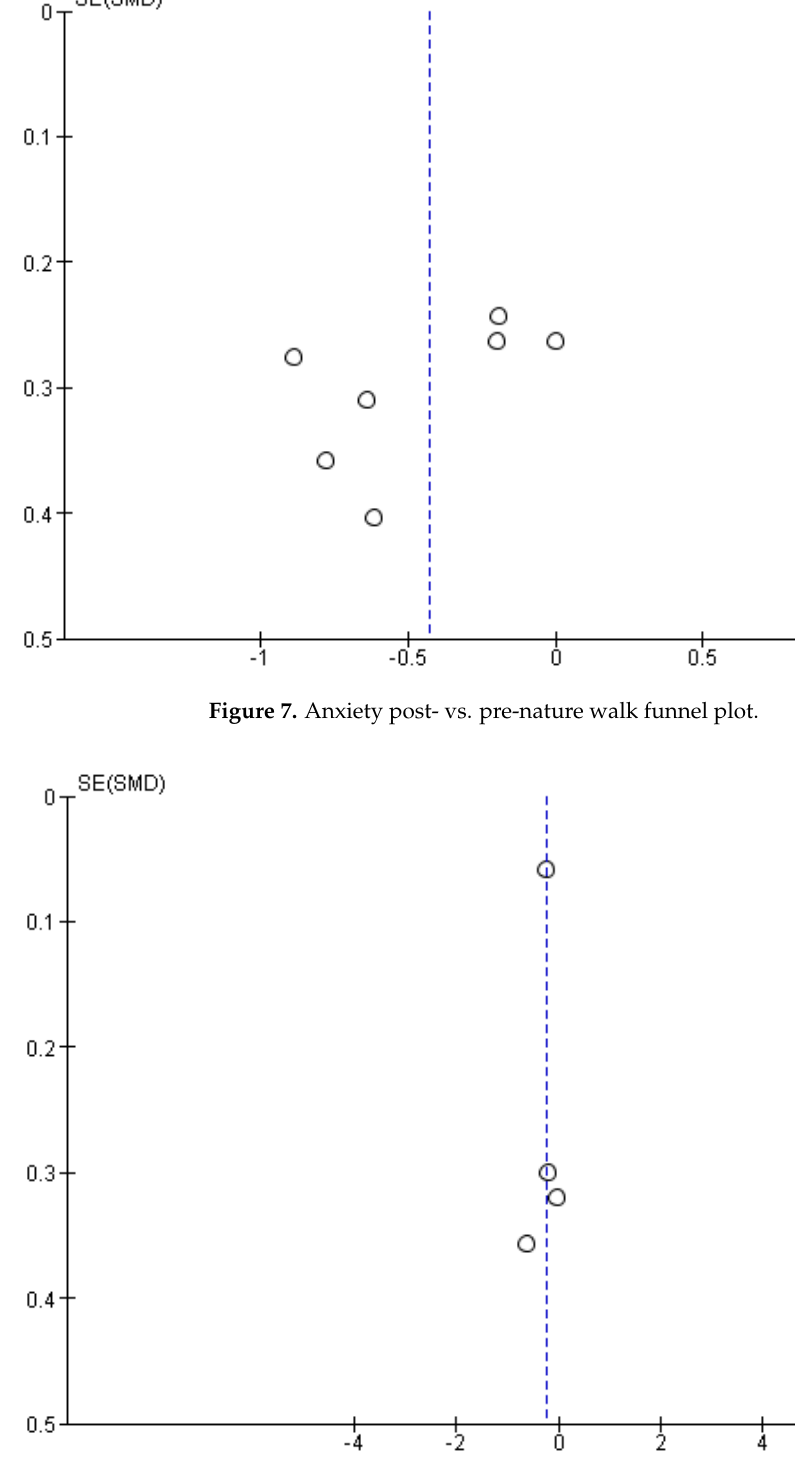
Figure 8. Depression nature walk vs. control funnel plot.